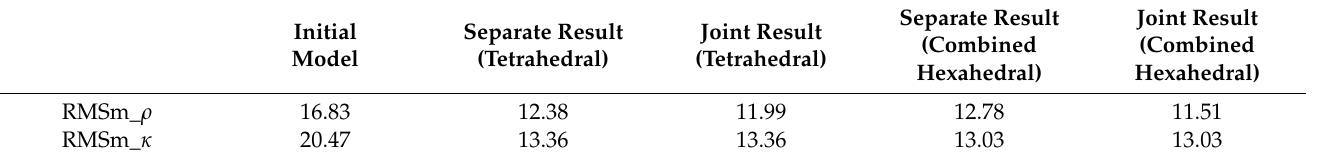
Figure 15. Cross-gradient descent rate of joint inversion under different Λ j 0 ρ . Table 3. RMSm of inversion results.